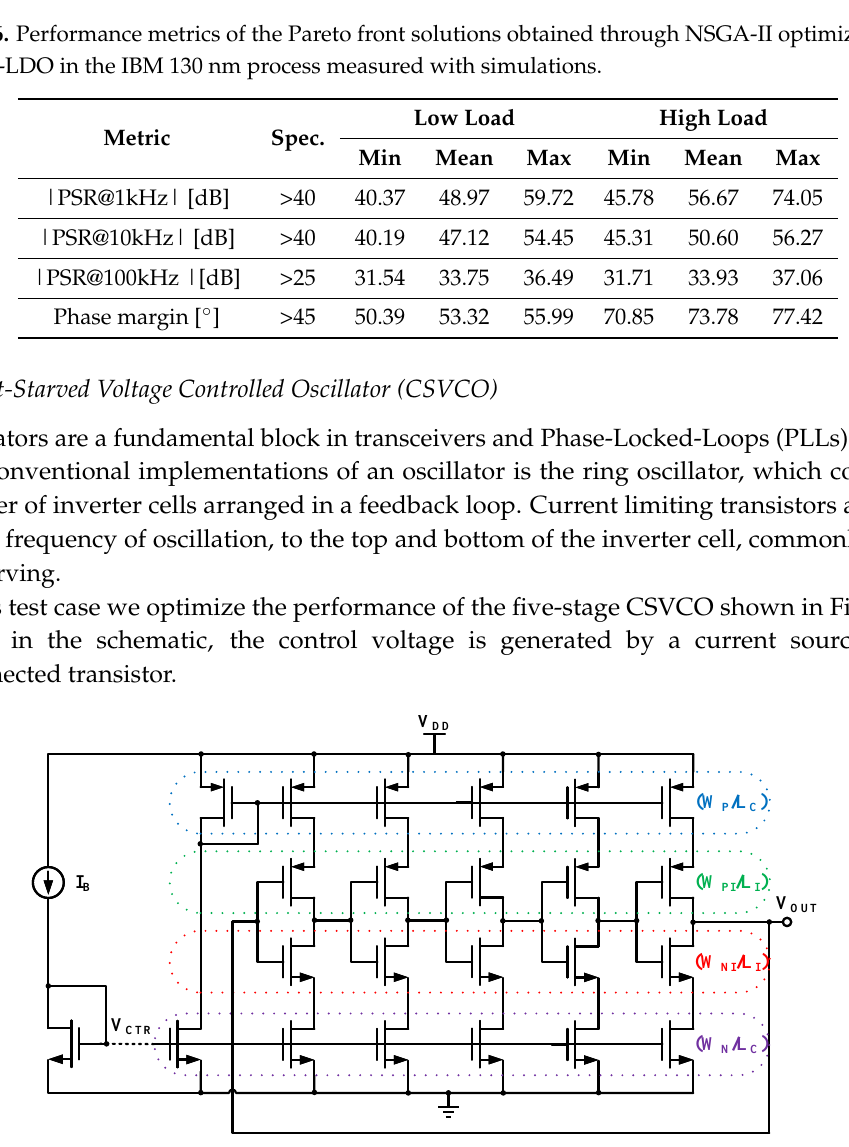
Figure 13. Circuit schematic of a 5-stage current starved voltage controlled oscillator (VCO). The control voltage is generated with a biasing current and a diode connected